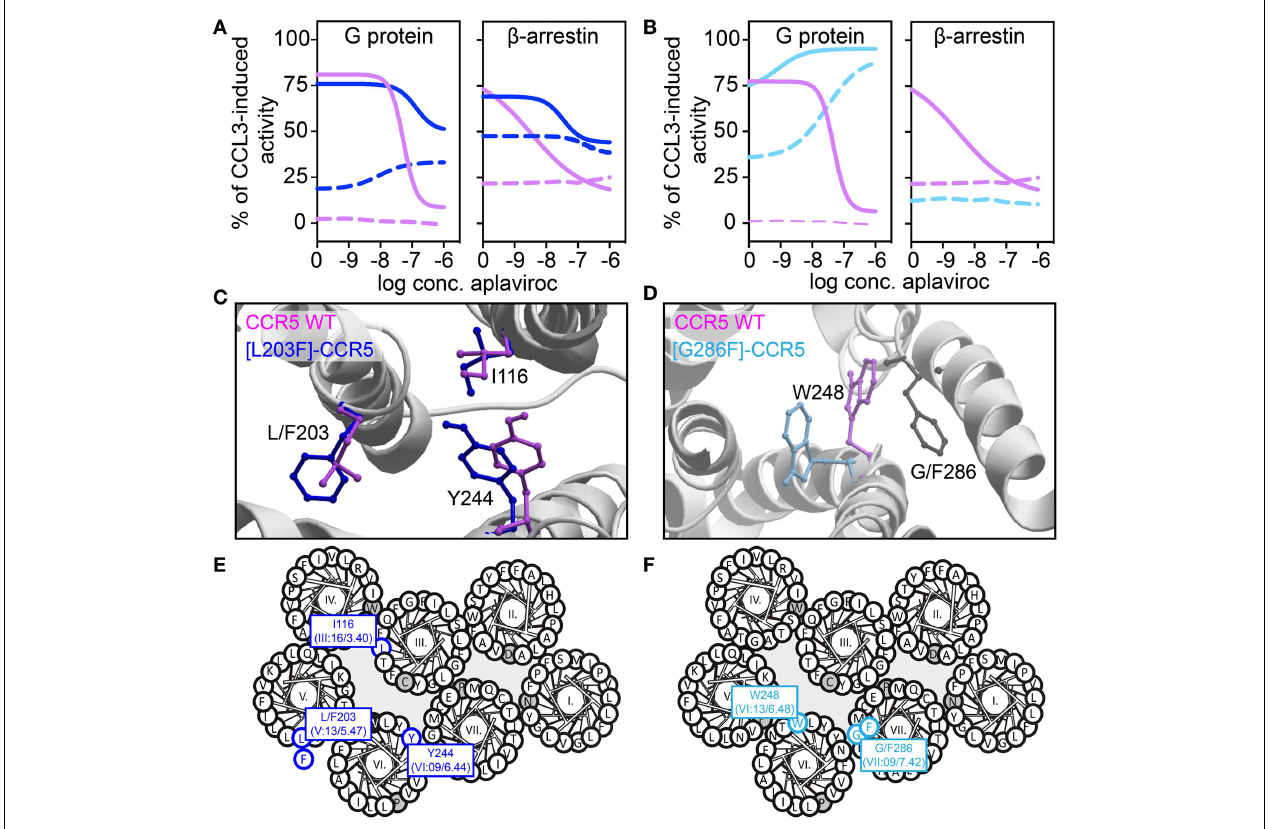
lines) the endogenous ligand CCL3. (C,D) Computational models of theWT and mutant receptors depicting the difference in side chain conformations of important amino acids. (E,F) Helical wheel diagrams showing the positions of relevant amino